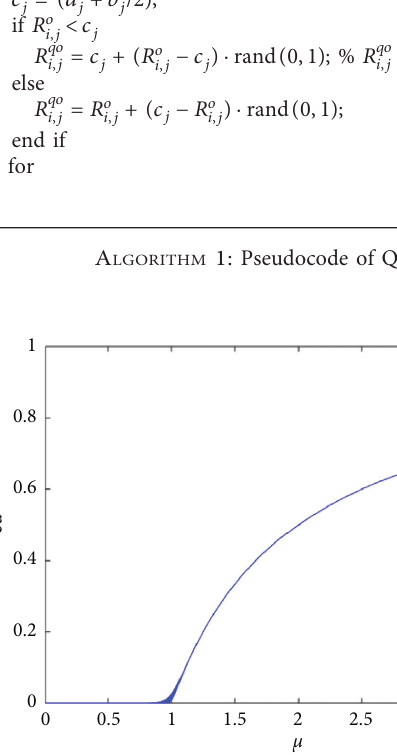
Figure 2: Bifurcation diagram of logistic